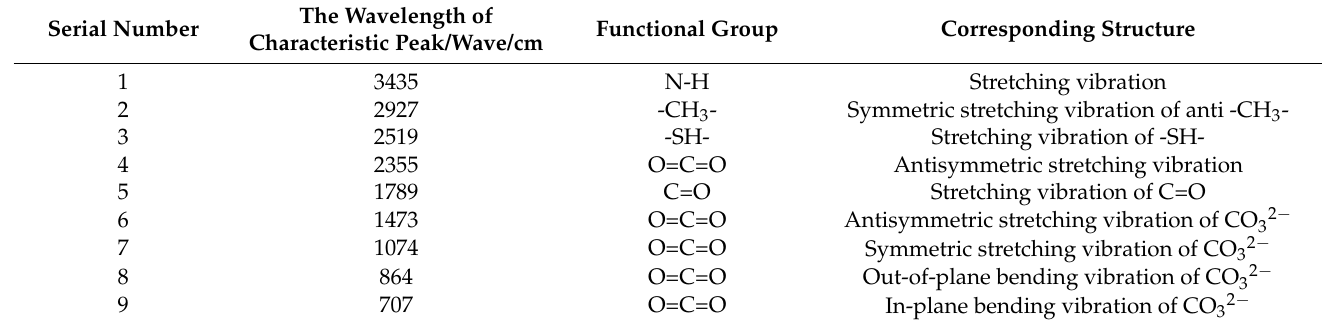
Figure 6. Structural changes of shell composites at the interface of scallops under ultra-high pressure. Except for the four obvious peaks possessed by calcium carbonate crystals that are manifested in the infrared spectrum of scallop shells, the emergence of protein and chitin characteristics peaks at 3435, 2927, 2519, 2355, and 1789 wave/cm indicates that a small number of organic substances exist in scallop shells. Each infrared characteristic peak, functional groups, and corresponding structures [38] are as shown in Table 1. Table 1. Comparison table of infrared spectrum characteristic peak and corresponding